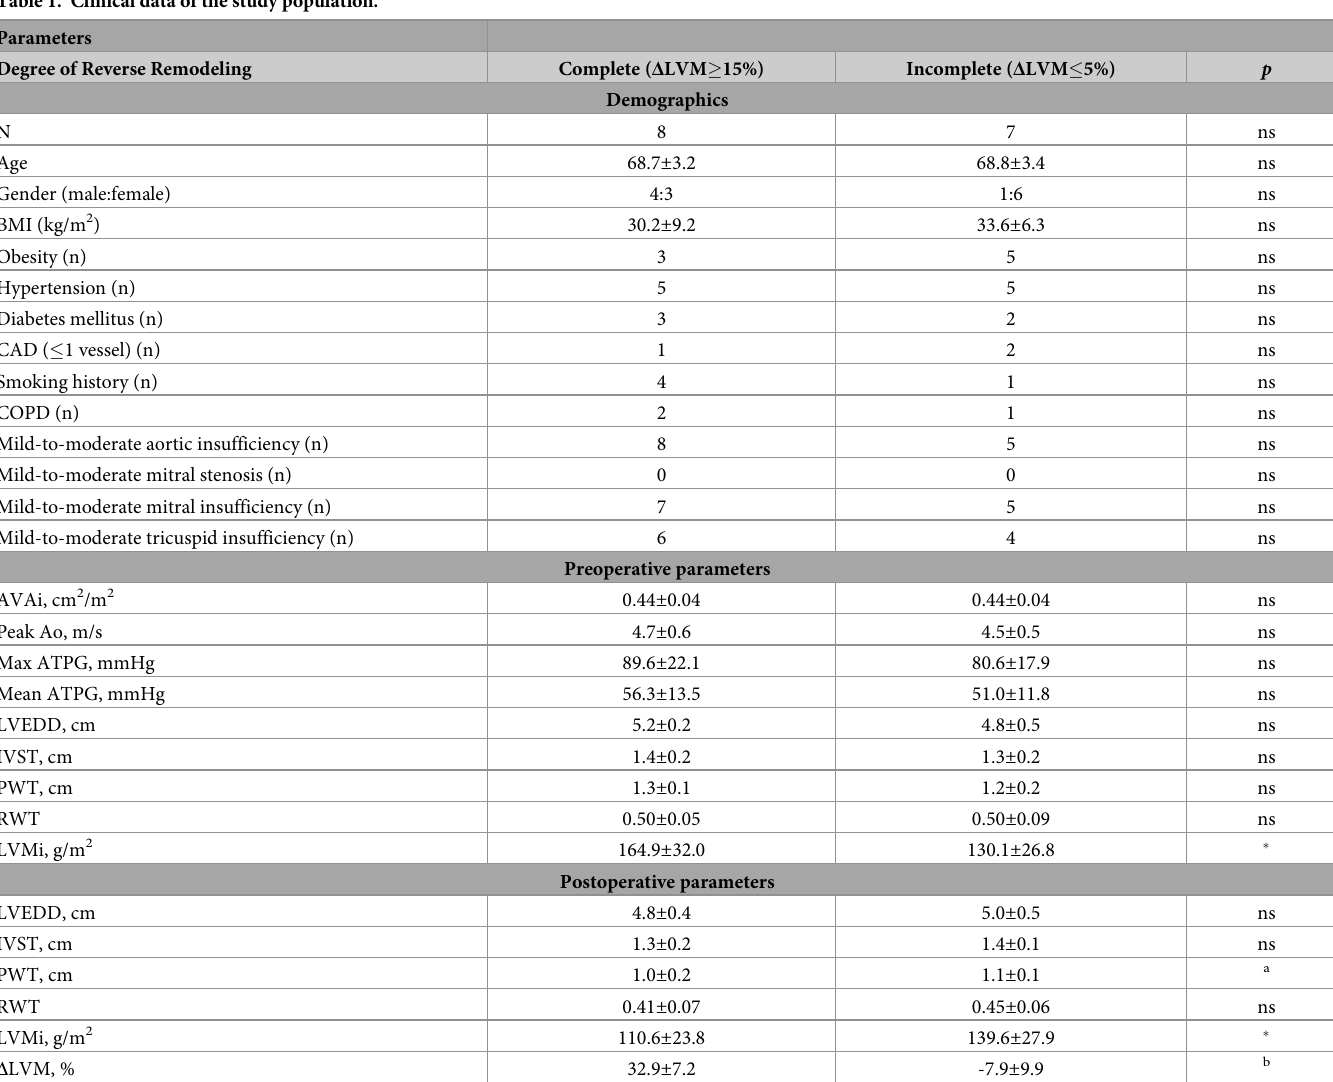
Table 1. Clinical data of the study